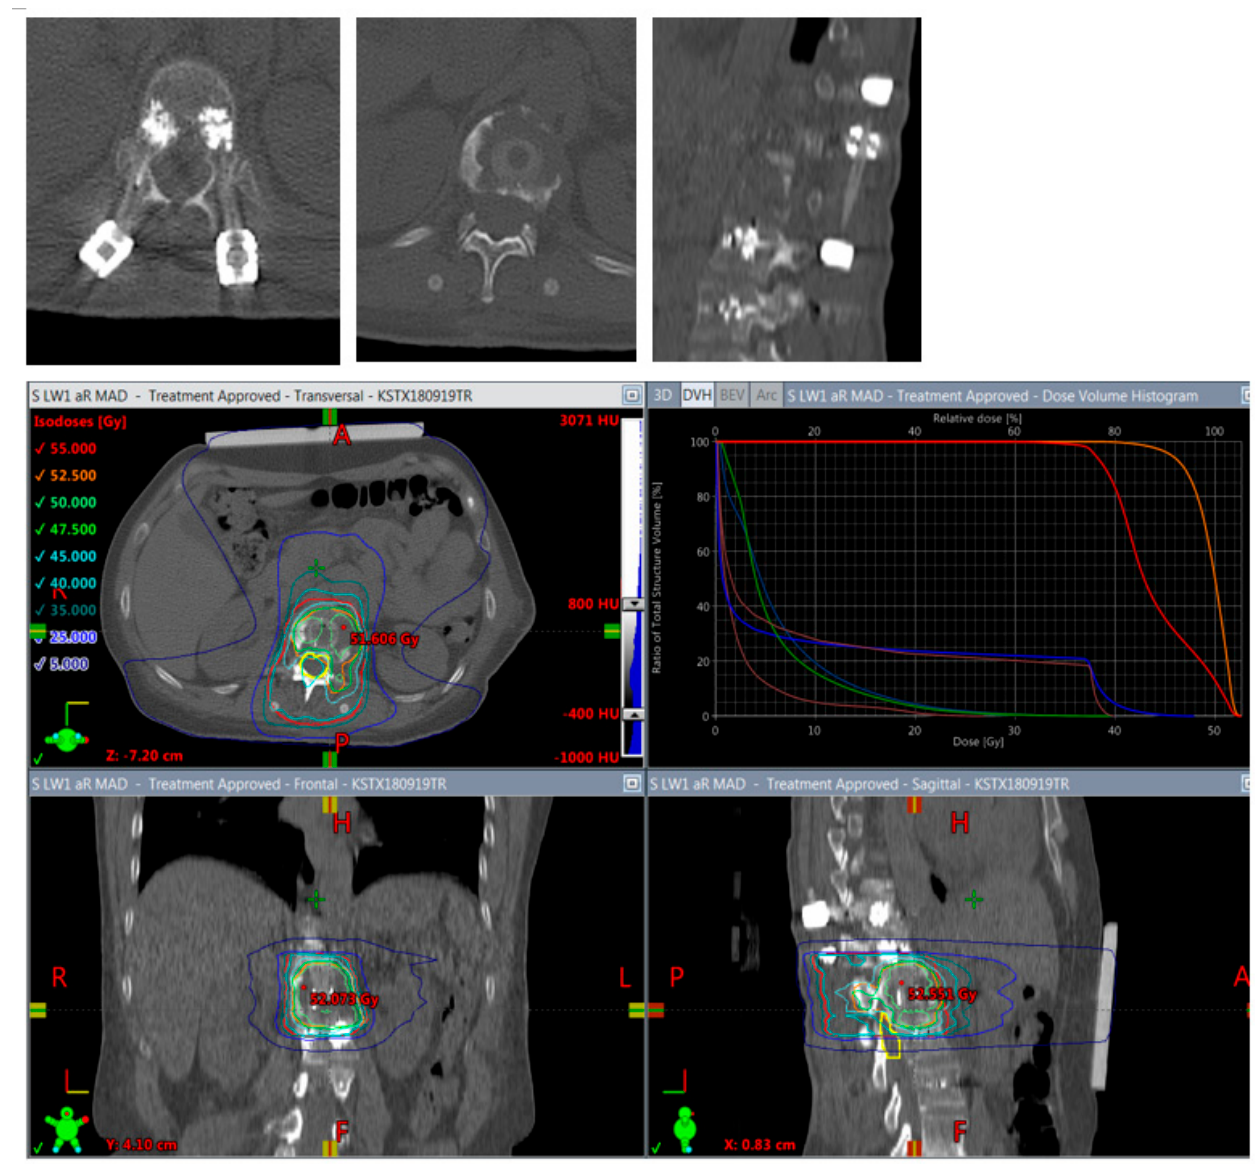
Figure 6. Planning of postoperative radiotherapy: CFR-PEEK. Less artifacts allow smaller volume radiotherapy of 40/50 Gy á 2/2,5 Gy of the vertebral body alone. Dose escalation is possible and there is less risk to the spinal cord and others structures at